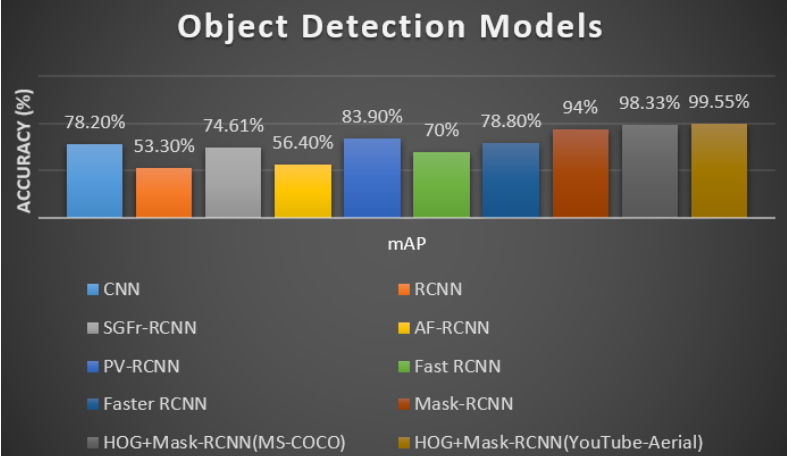
Figure 18. Bar graph of object detection models.